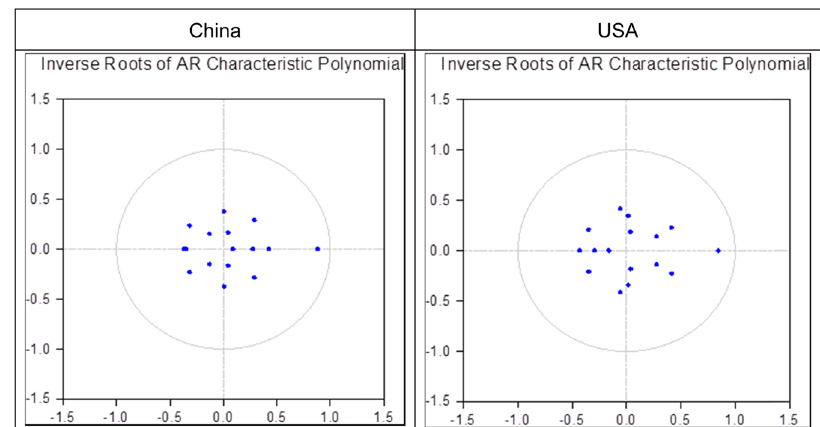
Fig. 1 Inverse roots of AR characteristic polynomial for China and USA.